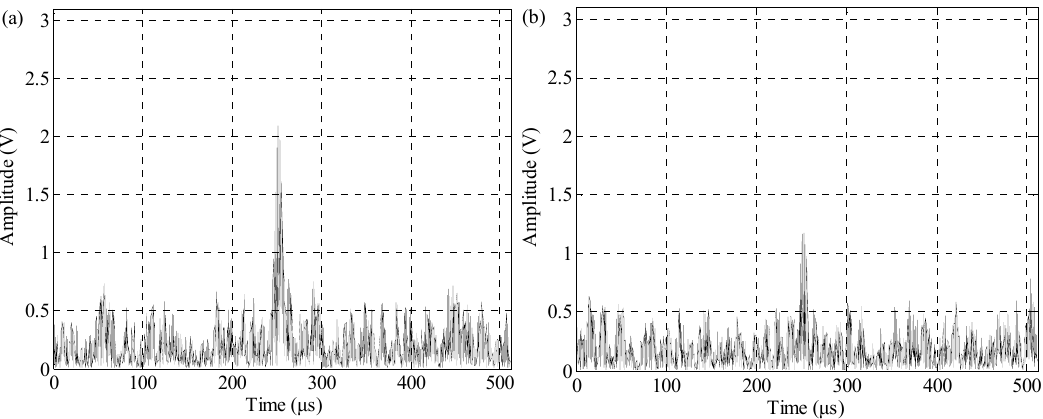
Figure 11. The P3 polyphase coded pulse compression signals are collected separately from the defect area and the intact area. ( a ) is the compressed signal collected in the intact area, and ( b ) is the compressed signal collected in the defect area.